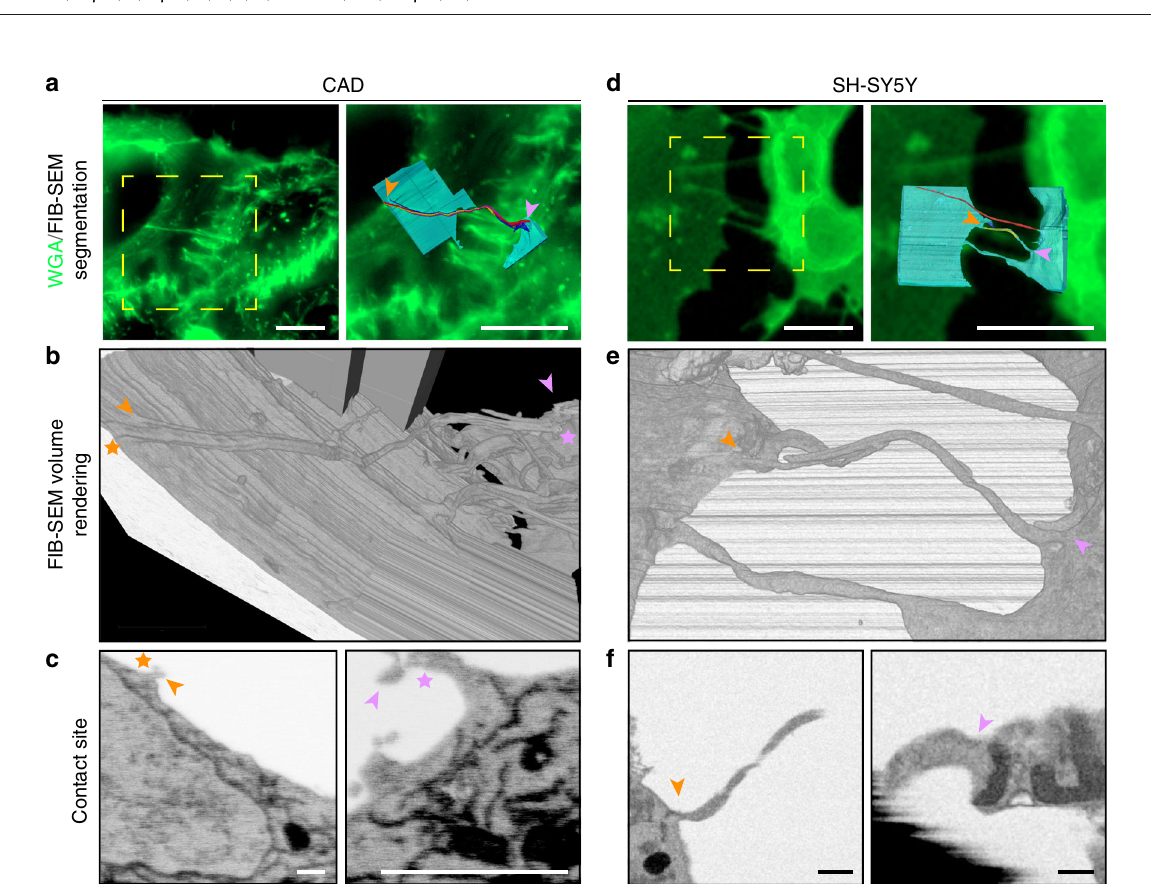
Fig. 7 FIB-SEM of TNTs in CAD and SH-SY5Y cells open-open contact sites. a , d Confocal micrographs of TNT-connected CAD ( a ) and SH-SY5Y ( d ) cells stained with WGA (green). Yellow dashed boxes in a and d (left) show the regions of interest chosen for FIB-SEM volume acquisition. A magni fi ed view of these regions is shown in a and d (right) overlaid with their FIB-SEM segmented rendering counterpart. Segmented cell bodies and single open-ended connections are shown in cyan. Open-ended iTNTs are shown in blue, yellow, and magenta. Single close-ended protrusions are shown in red. Orange and pink arrowheads indicate contact sites with cells. b , e Renderings of FIB-SEM volumes produced by the Amira software are shown for CAD ( b ) and SH-SY5Y ( e ) cells. c , f Single frames obtained from the raw FIB-SEM data of CAD cells ( c ), obtained at a pixel size of 2.5 nm and displayed in an x-y orientation, and SH-SY5Y cells ( f ) obtained at a pixel size of 10 nm and displayed in an x - z orientation. Panels show TNT-to-cell contact sites at both ends of the connection: orange arrowhead (left); pink arrowhead (right). Scale bars: a , d , 10 μ m; c , f , 500